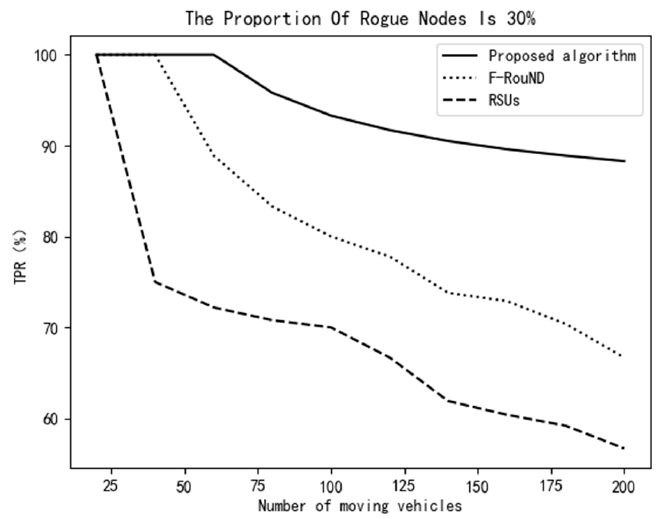
Figure 11. Variation of TPR vs. the number of mobile vehicles (30%).